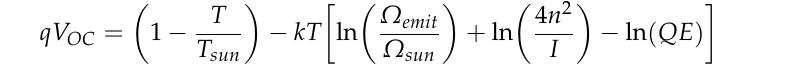
Table 2. Electrical performance of the constructed DSSC using various photoanodes and dye types. Dye Photoanode J sc (mA/cm 2 ) V oc (V) FF η (%) TiO 2 0.82 1.18 0.40 0.39 Blueberry ZnO 7.12 0.79 0.50 2.81 TiO 2 5.86 0.35 0.45 0.93 Pomegranate ZnO 7.12 0.71 0.60 3.03 TiO 2 6.69 0.52 0.30 1.05 Black grape ZnO 9.72 0.73 0.51